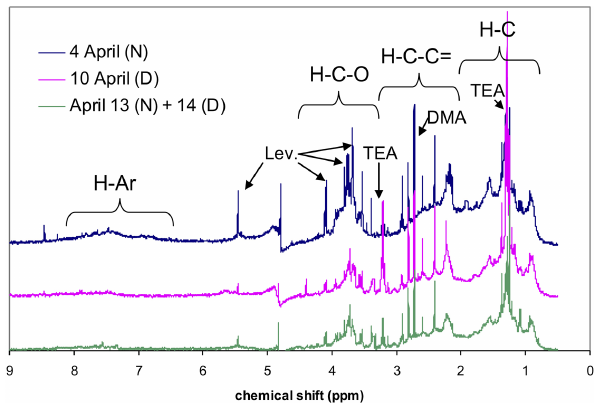
Figure 2. Examples of 1 H-NMR spectra of different aerosol SPC 2008 EUCAARI